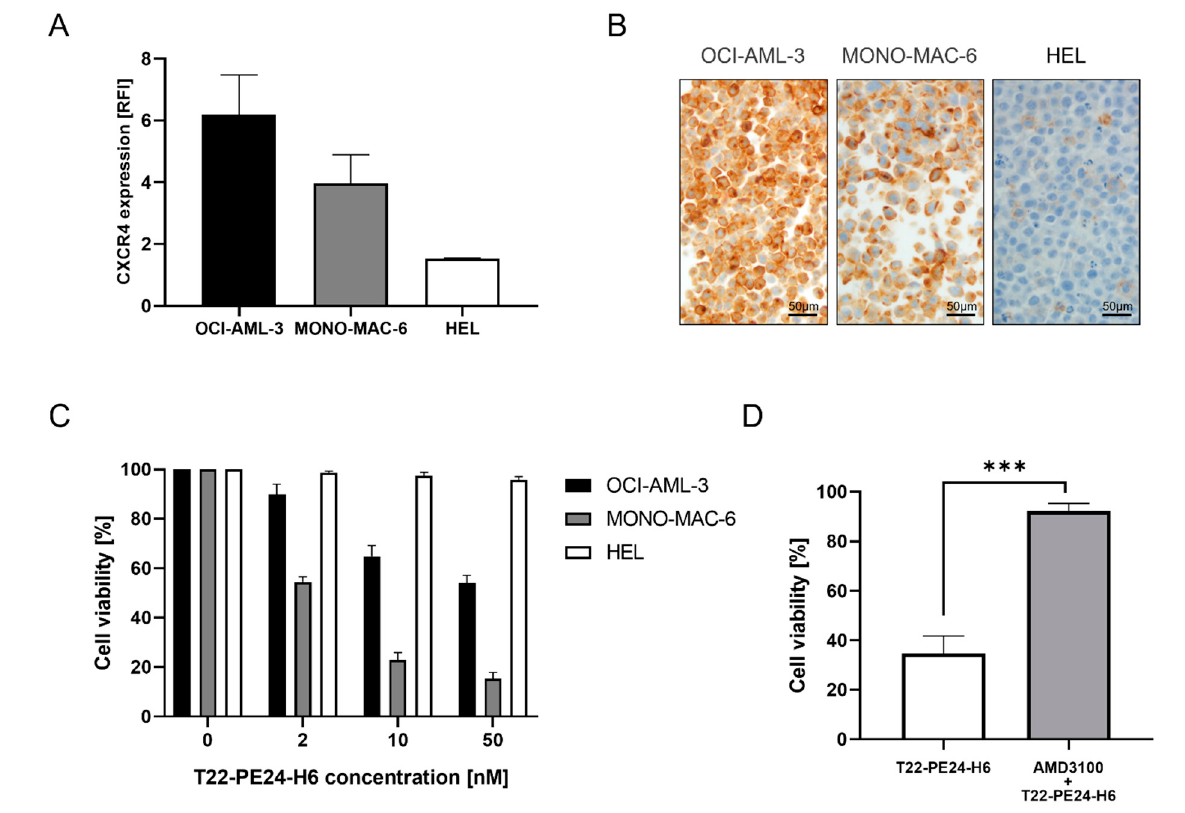
Figure 1. Determination of CXCR4 expression intensity and T22-PE24-H6 cytotoxic effect in AML cell lines. ( A ) CXCR4 membrane expression of AML cell lines by flow cytometry. Data acquisition was analyzed by Cell Quest Pro software, and results are expressed as RFI normalized by the isotype. ( B ) IHC analysis of CXCR4 expression in OCI-AML-3, MONO-MAC-6, and HEL cell blocks. ( C ) Evaluation of the antineoplastic activity of T22-PE24-H6 (0, 2, 10, and 50 nM) after 48 h of treatment in AML cell lines performed by the XTT assay. ( D ) Competition assays with the preincubation of AMD3100 followed by the T22-PE24-H6 addition (100 nM AMD3100: 10 nM T22-PE24-H6) in the MONO-MAC-6 cell line. An unpaired t test was used to test the differences between the groups indicated by *** when the p -value was ≤ 0.005. The results are expressed as mean ± SEM. Original magnification × 400 for panel B. AML: acute myeloid leukemia; RFI: relative fluorescence intensity.